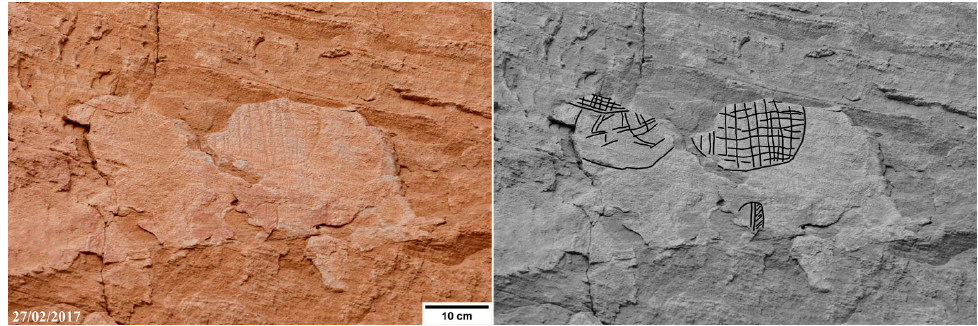
Figure 19. An oval engraving (E6) preserved for its central portion only, internally decorated with horizontal stripes filled by angled grids (black and white version: interpretation by tracing, Photo: Alessandro Menardi Noguera).